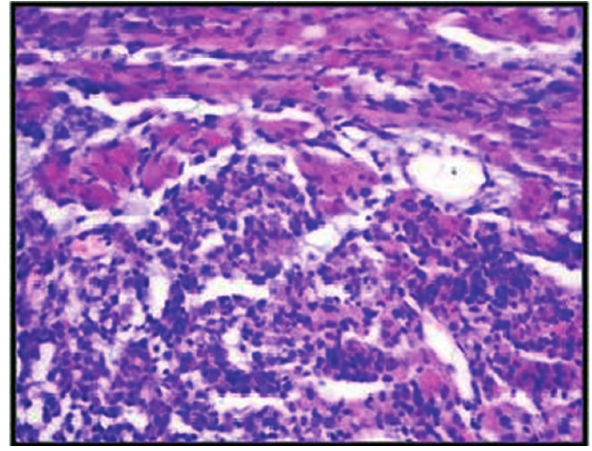
3)Fig. 3 - Estudo histopatológico demonstrando tecido miocárdico com alterações histológicas moderadas (Grau